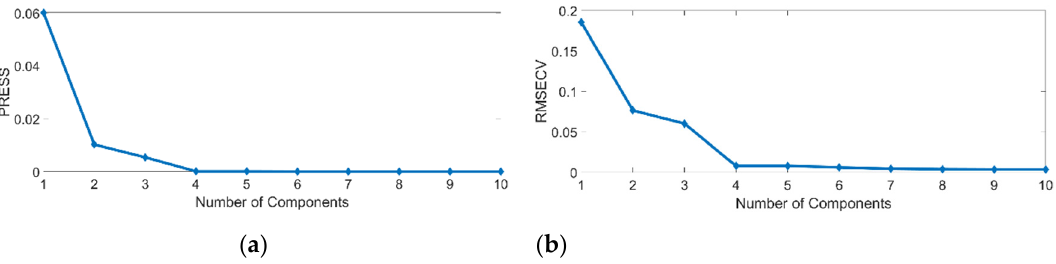
Figure 7. Plot of HVO quantification PLS model performance values of cross validation versus the number of components: ( a )—PRESS; ( b )—RMSECV.